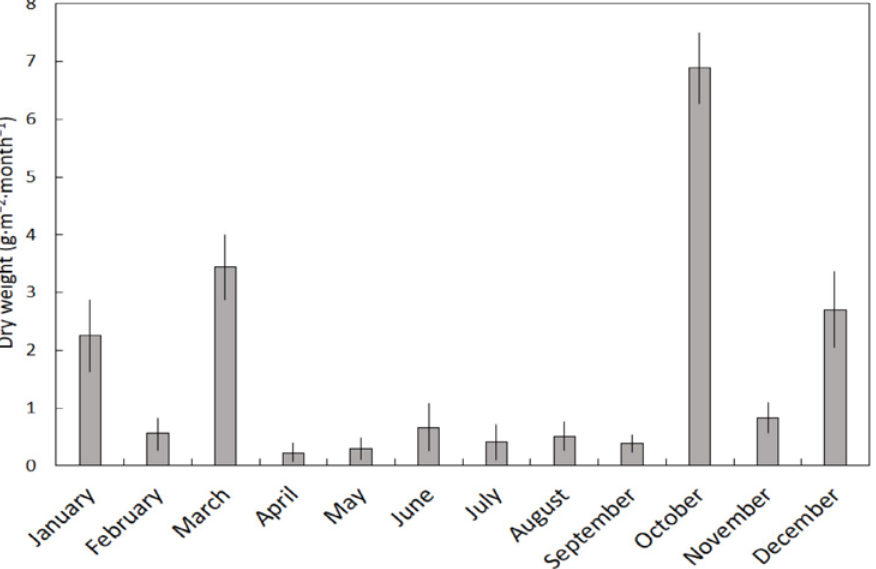
Figure 2. The influence of month on fruit litterfall beneath a Serianthes nelsonii tree. Mean ± SE, n = 6.